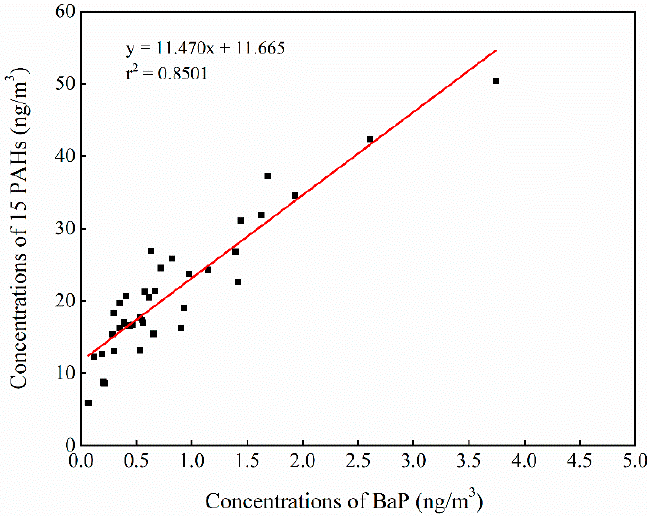
Figure 4. Linear relationship of 15 PAHs and benzo[a]pyrene (BaP) in the study area during the monitoring